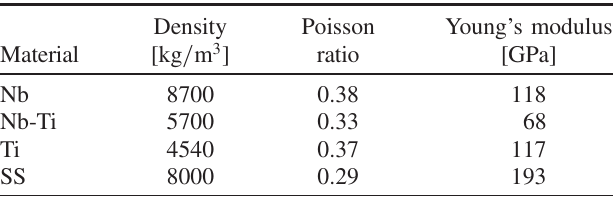
TABLE I. Mechanical properties of the dressed cavity materials.